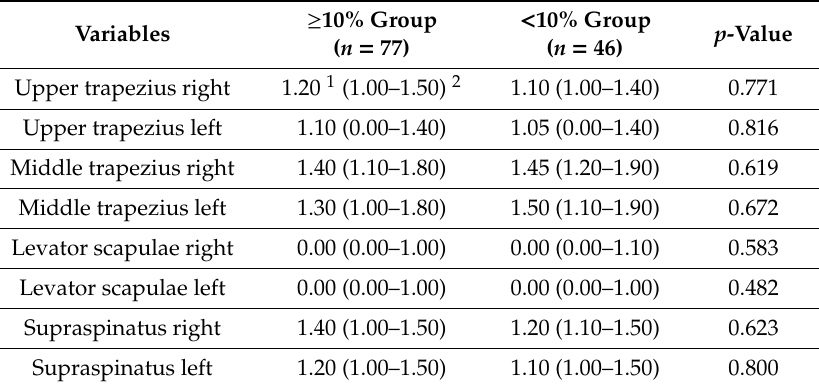
Table 4. Pressure pain threshold in kg / cm 2